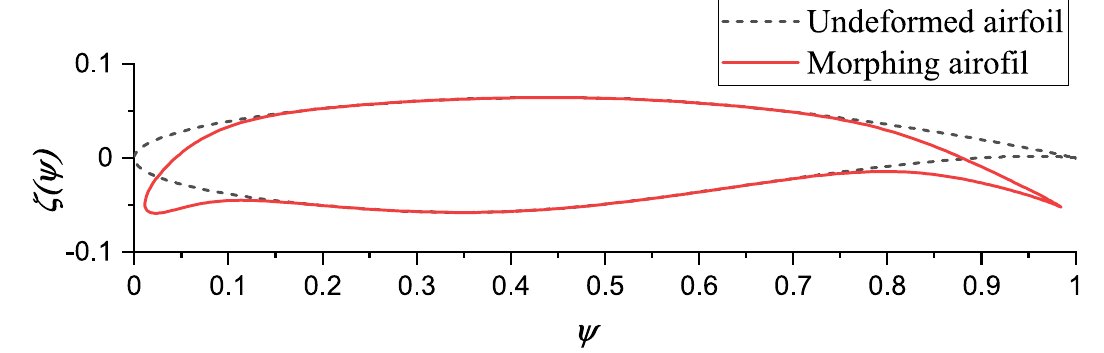
Figure 4. RAE 2822 with morphing leading and trailing